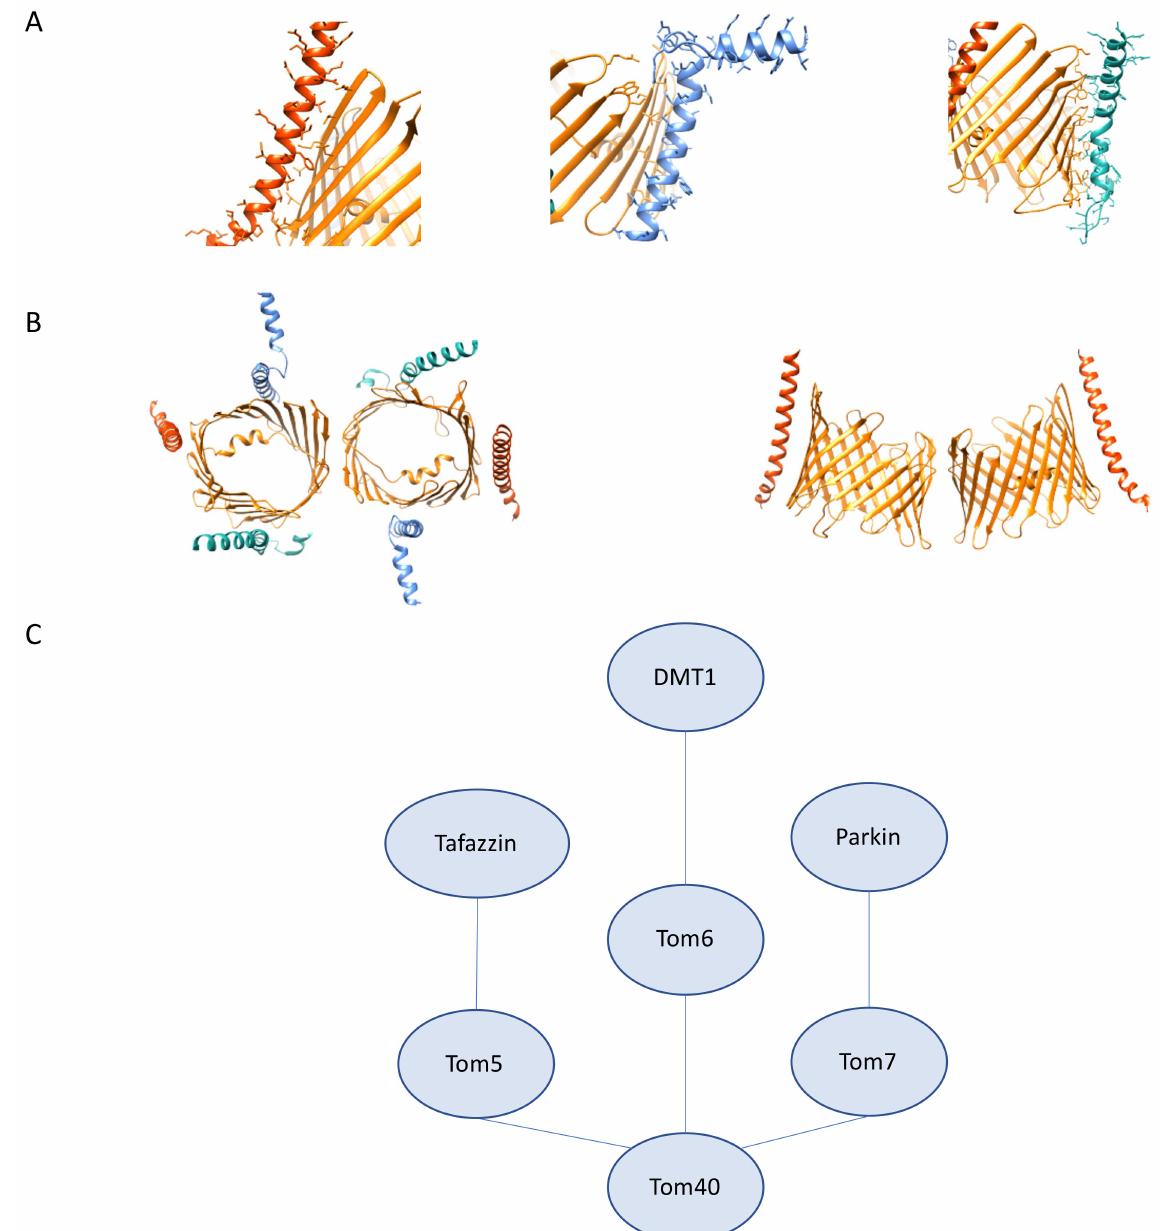
Figure 6. Tom5, Tom6, Tom7 structural features and interactions. ( A ) High resolution structure of human Tom5, 6, 7 (PDB:7ck6). ( left ) Tom5 (vermillion) interactions with Tom40 (orange). ( middle ) Tom6 (light blue) interactions with Tom40 (orange). ( right ) Tom7 (seafoam green) interactions with Tom40 (orange). ( B ) ( left ) Tom5 (vermillion), Tom6 (light blue) and Tom7 (seafoam green) cytosolic view showing arrangement around the β -barrel ( right ). Curvature of Tom5 along Tom40 (orange). ( C ) Tom5, Tom6, Tom7 interactions as described. Distances do not represent interaction